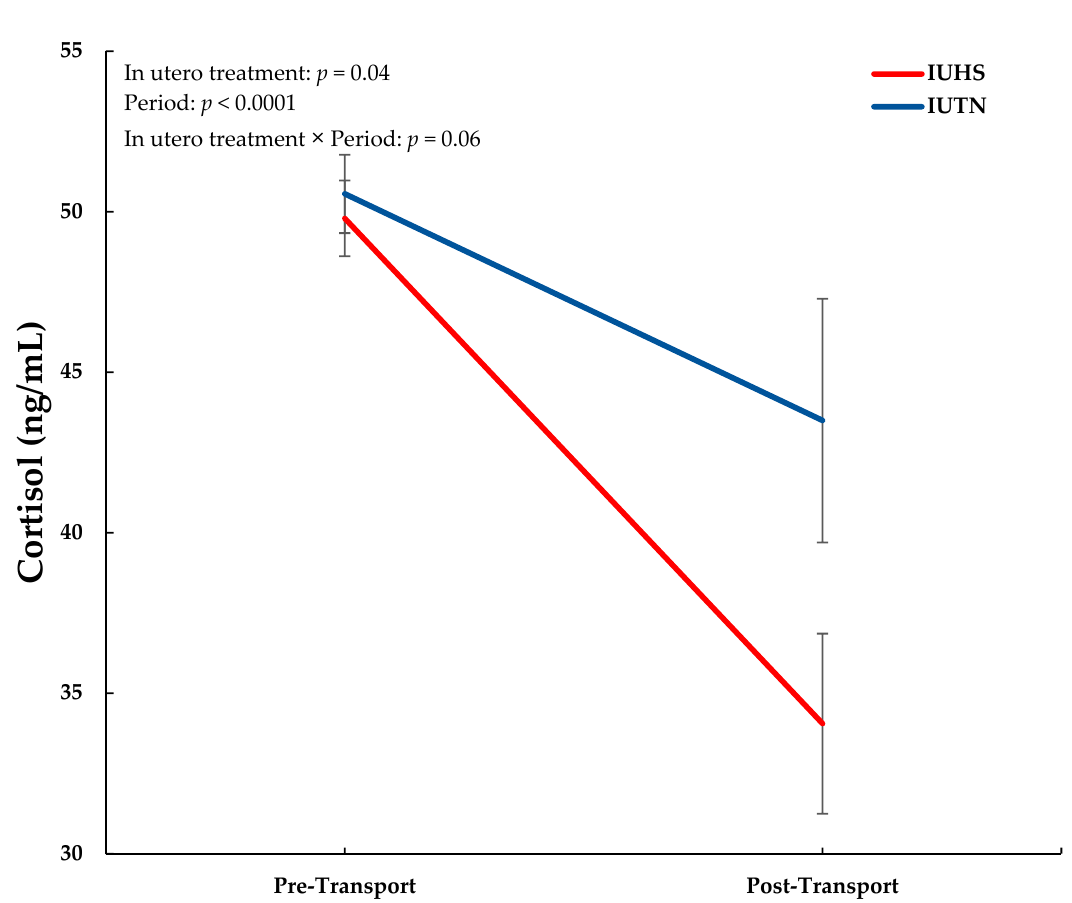
Figure 1. Piglet plasma cortisol concentrations organized by in utero treatment (thermoneutral (IUTN) and in utero heat stress (IUHS)) and period (pre-transport and post-transport). Table 2. Least squares means of circulating concentrations of NEFA (non-esterified fatty acids), insulin Non-esterified fatty acid concentrations were increased overall post-transport compared to pre- and transport (923.5 ± 222.9 and 721.6 ± 225.1 mEq/L, respectively; F 1,18.77 = 18.77; p = 0.009), regardless of